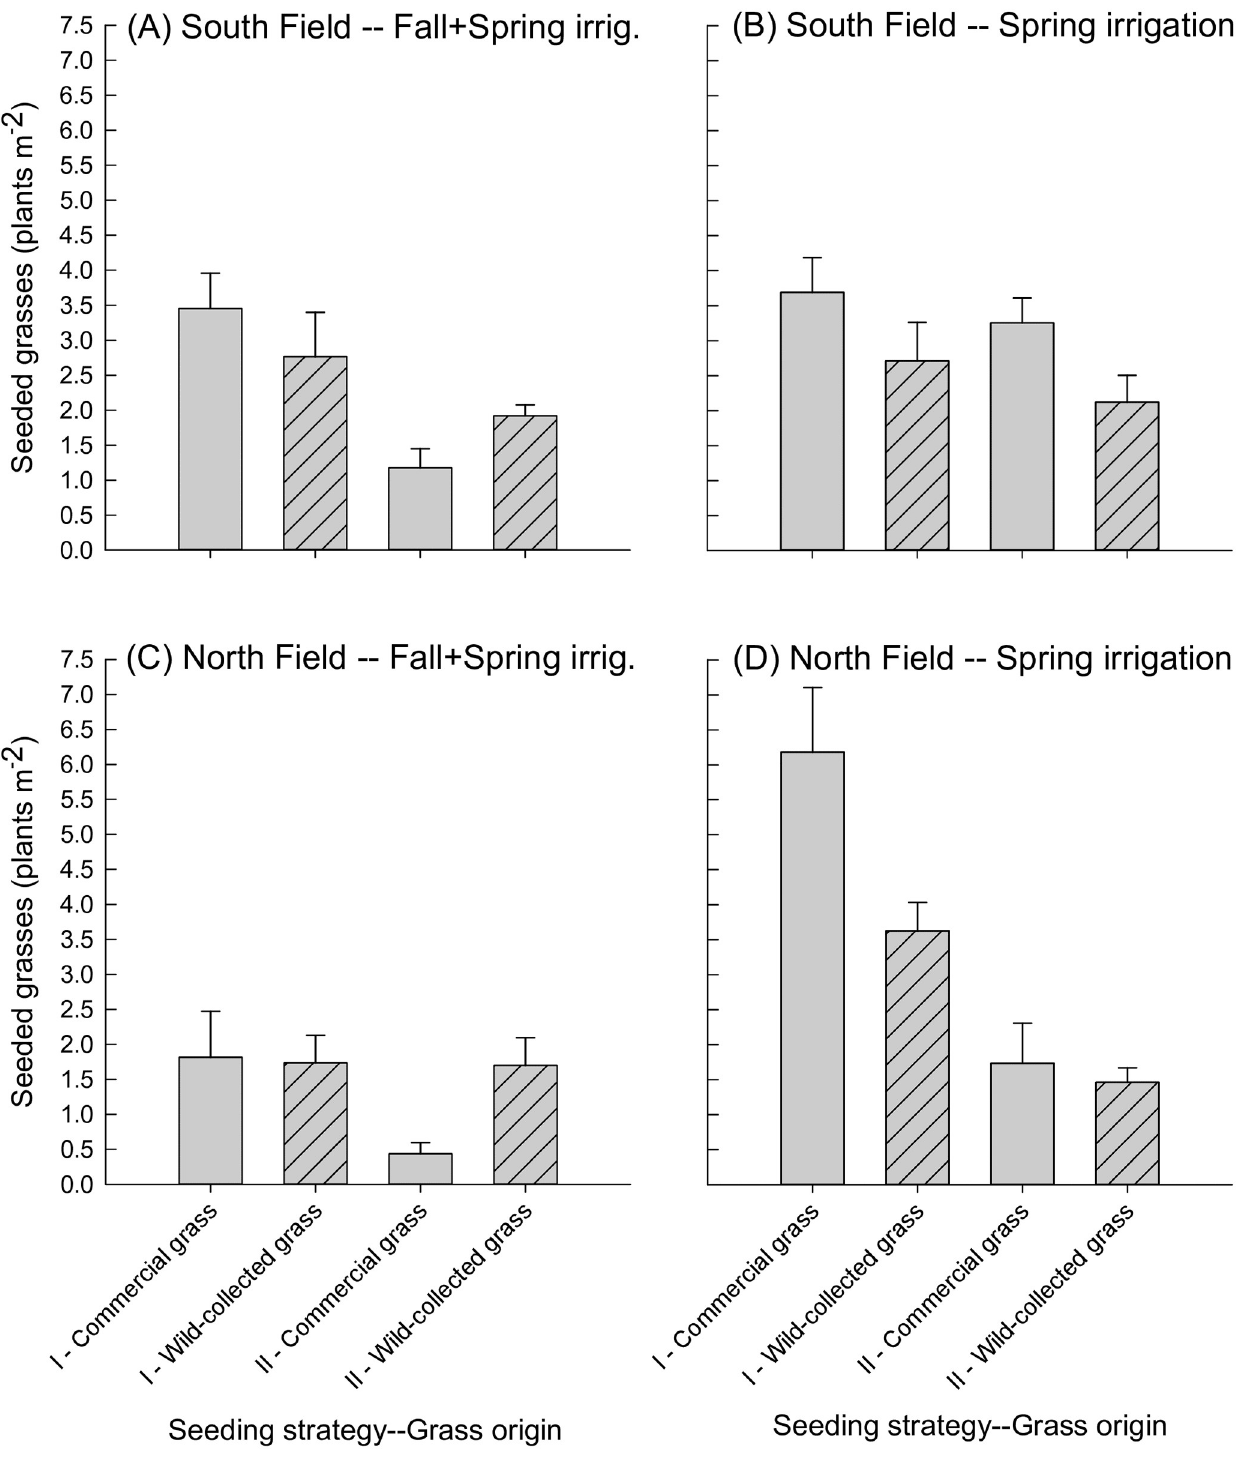
Fig 5. Seeded grasses in May 2016 at both sites, by irrigation treatment, seeding strategy, and grass origin. Seeded grasses (plants m -2 ) in May 2016, shown by seeding strategy (I or II) and grass origin for the (A) South Field, Fall+Spring irrigation, (B) South Field, Spring irrigation, (C) North Field, Fall +Spring irrigation, and (D) North Field, Spring irrigation. Grass seed origin is indicated by hash marks for local origin, or no pattern for commercial origin. Seeding strategies are described in Table 1. Note that grass species are not differentiated here because grass seedlings were difficult to identify with certainty at this young